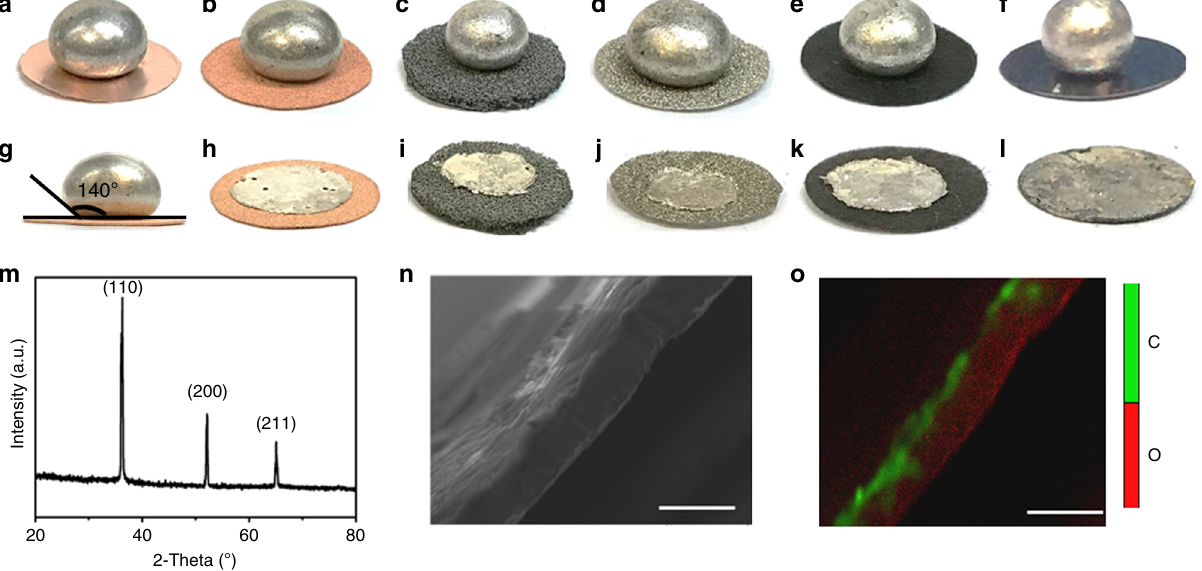
Fig. 4a, b) con fi rms the existence of methyl and methylene groups (2900 cm − 1 ), as well as LiOH at the bottom surface of Li layer. X- ray photoelectron spectroscopy (XPS) was used to identify the